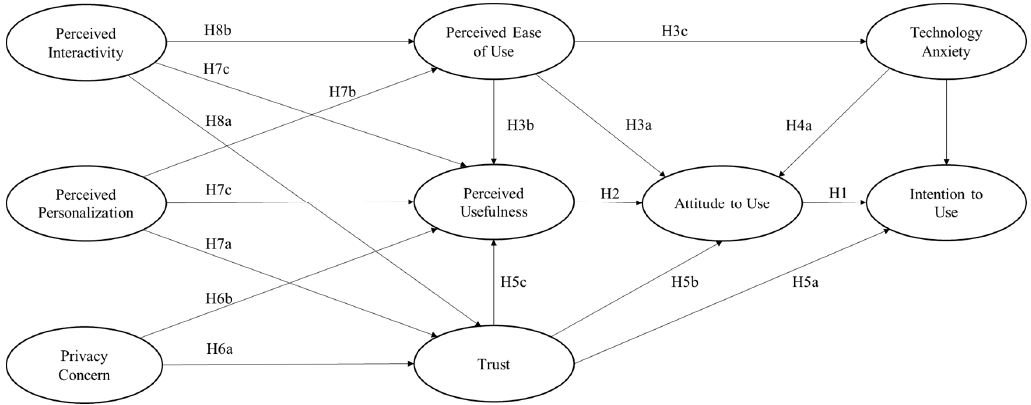
Figure 2. Research model of this study (Hypothesis denoted H). 2.1. TAM Constructs